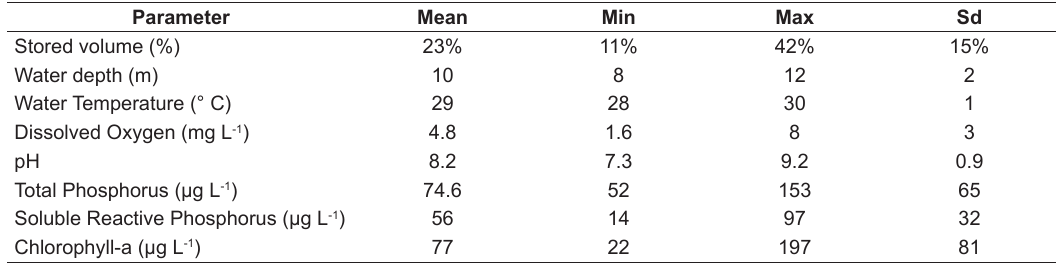
Table 1. Mean, minimum (Min), maximum (Max) and standard deviation (SD) of physicochemical variables and chlorophyll-a in Boqueirão reservoir water analyzed monthly from November 2017 to March